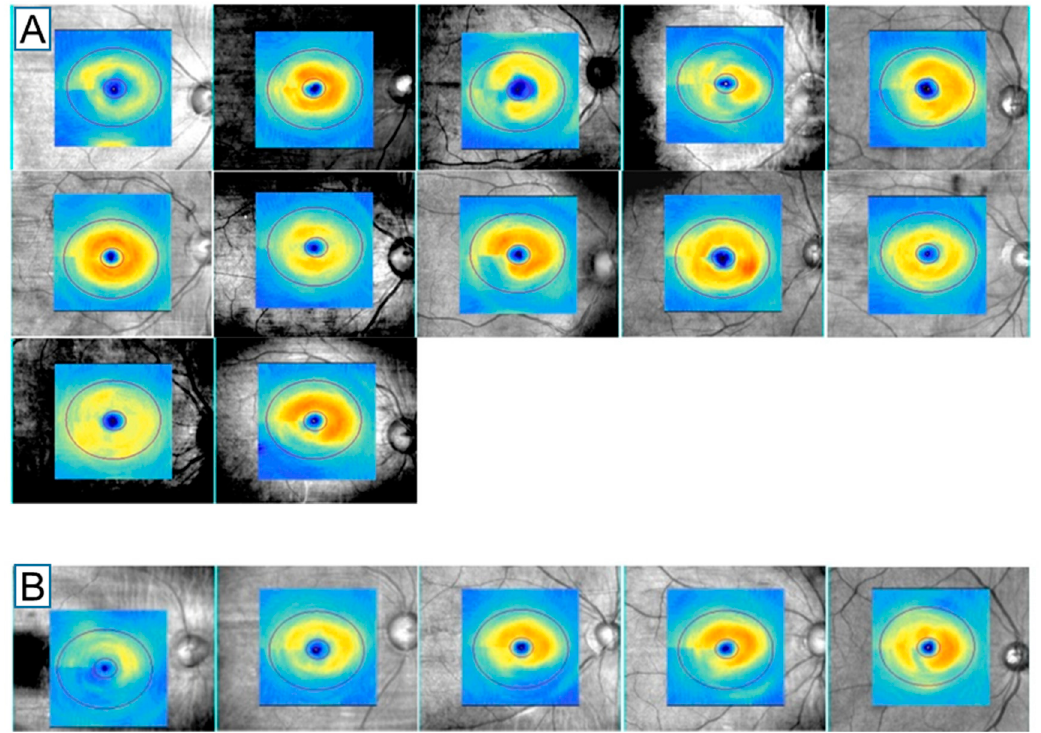
Figure 2. Thickness maps of the ganglion cell analysis (GCA) of ( A ) 12 retinal vein occlusion (RVO) patients diagnosed as primary open-angle glaucoma (POAG) by one or two examiners and ( B ) 5 POAG patients diagnosed as RVO by one or two examiners.